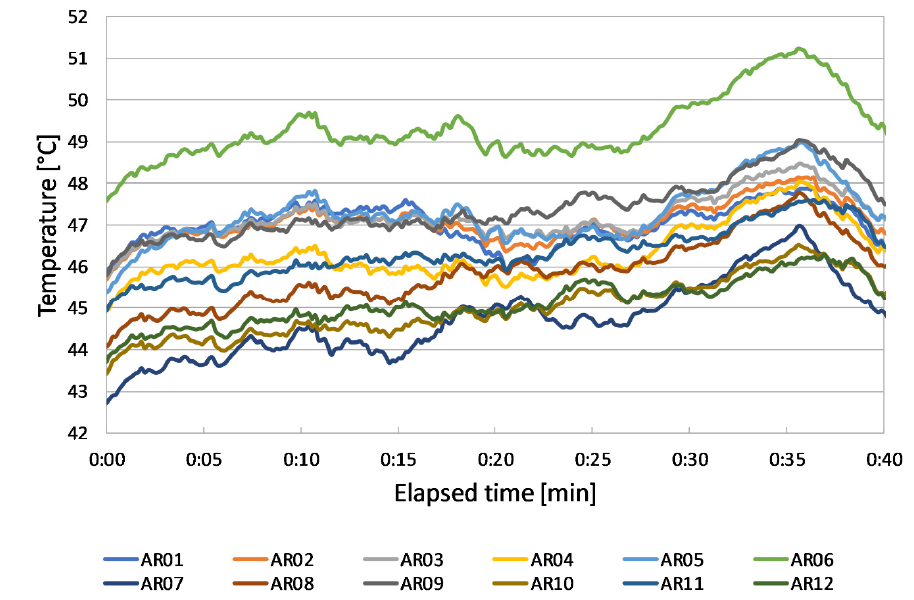
Figure 10. Panels’ temperature profiles during test 2 (29th August).